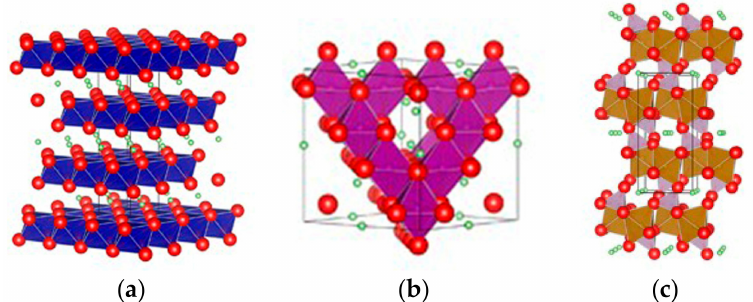
Figure 5. Crystal structure of: layered LiCoO 2 ( a ); spinel LiMn 2 O 4 ( b ); and olivine LiFePO 4 ( c ) (Reproduced with permission from